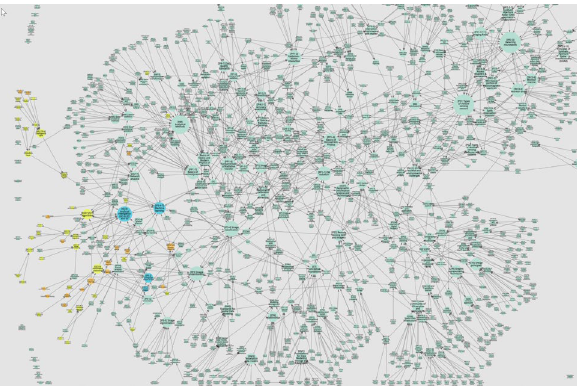
Figu re 5 . AI cluster integrated in existing BoK. The AI cluster appears on the